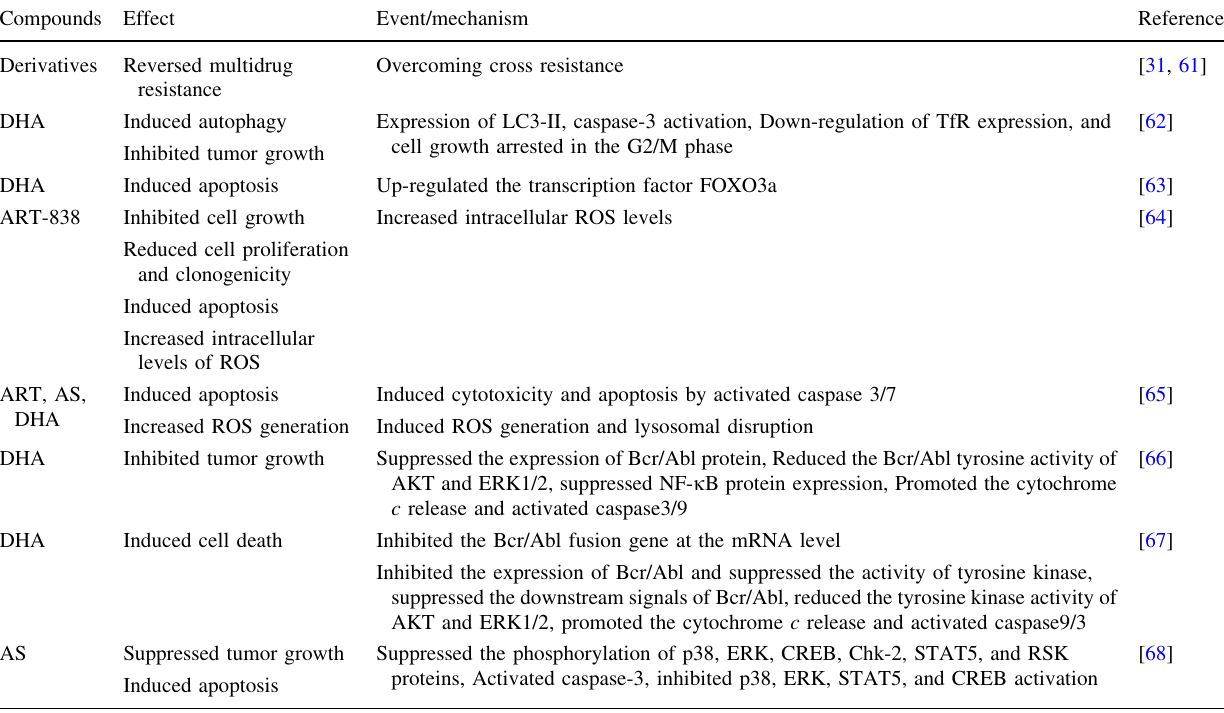
Table 1 Anti-leukemia cells activities of artemisinins Compounds Effect